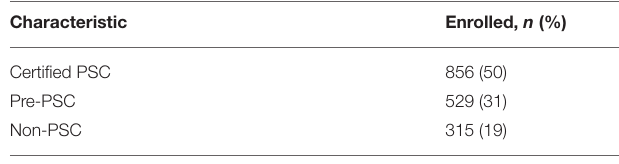
TABLE 1 | Patient enrollment at PSCs, pre-PSCs, and